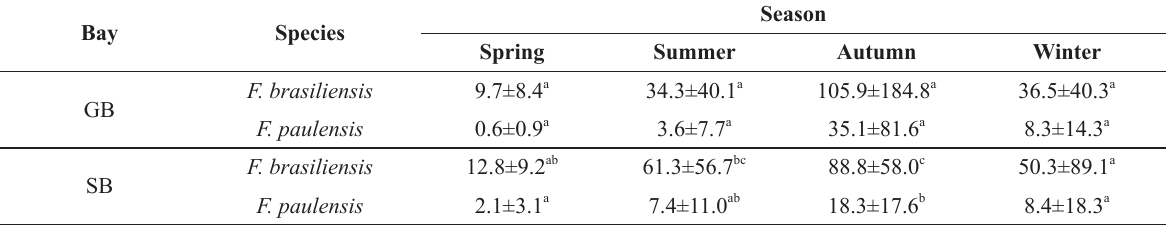
Comparison of CPUE average (nº ind/30-min haul) of pink shrimp species ( F. brasiliensis and F. paulensis ) per season.